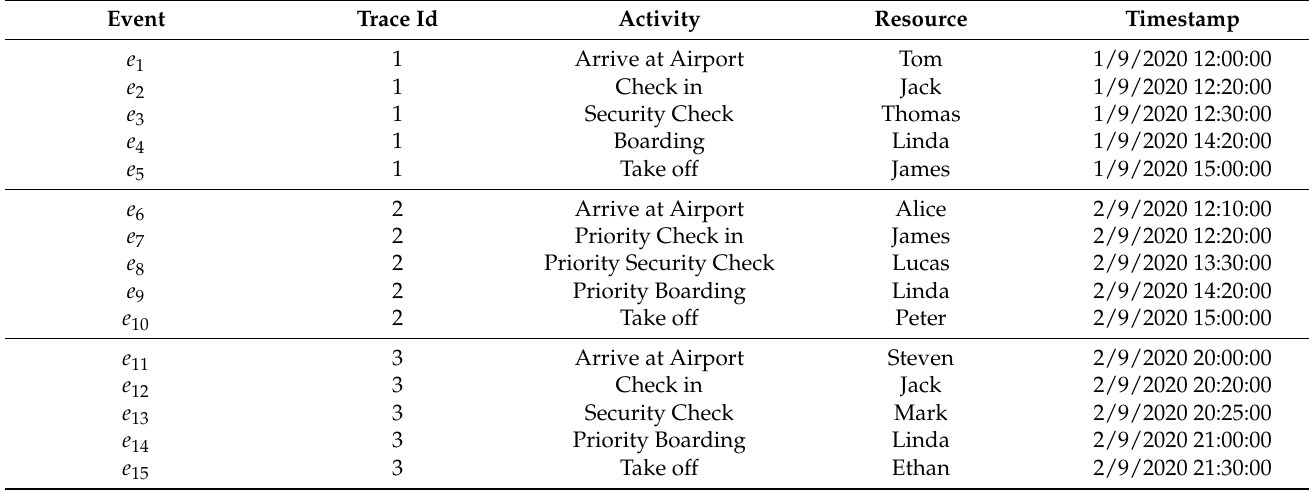
Table 1. An example event log L 1 without missing activity